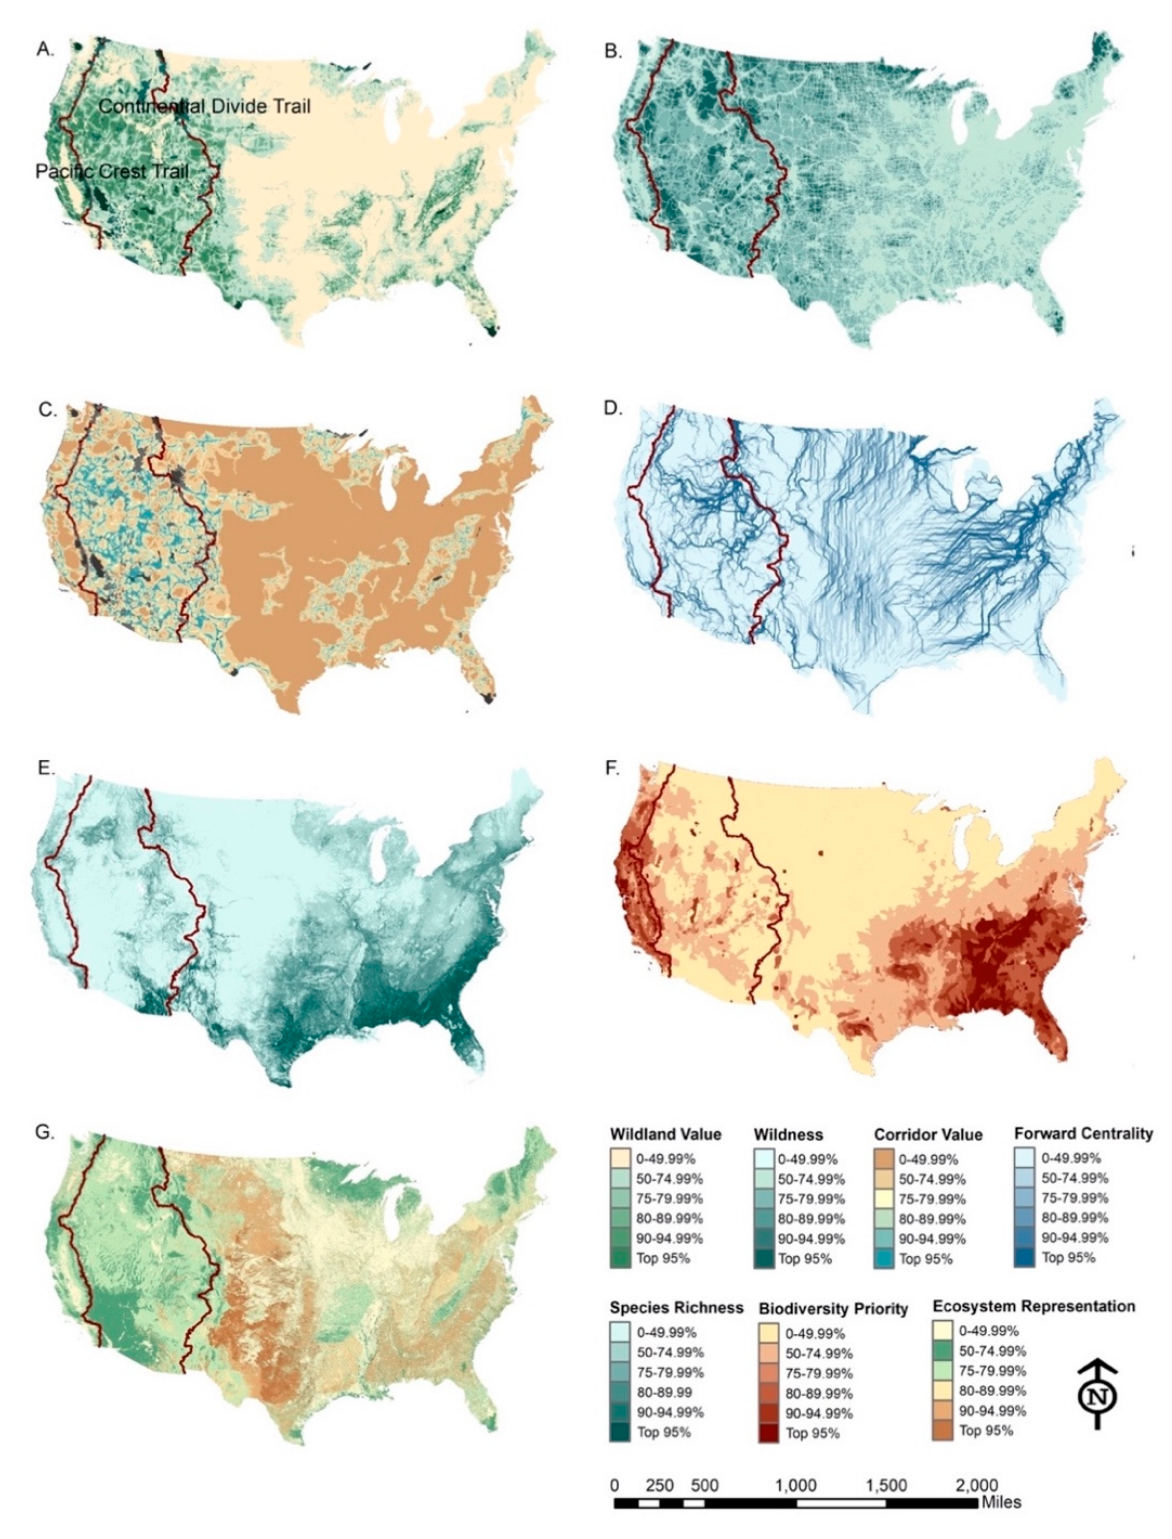
Figure 2. Values of the modeled wildlife corridors along the Pacific Crest Trail and the Continental Divide Trails. ( A ) Wildland conservation value [26]; ( B ) wildness [27]; ( C ) corridor value [5]; ( D ) forward centrality [24]; ( E ) species richness [25]; ( F ) biodiversity priority [22]; ( G ) ecosystem representation [8].